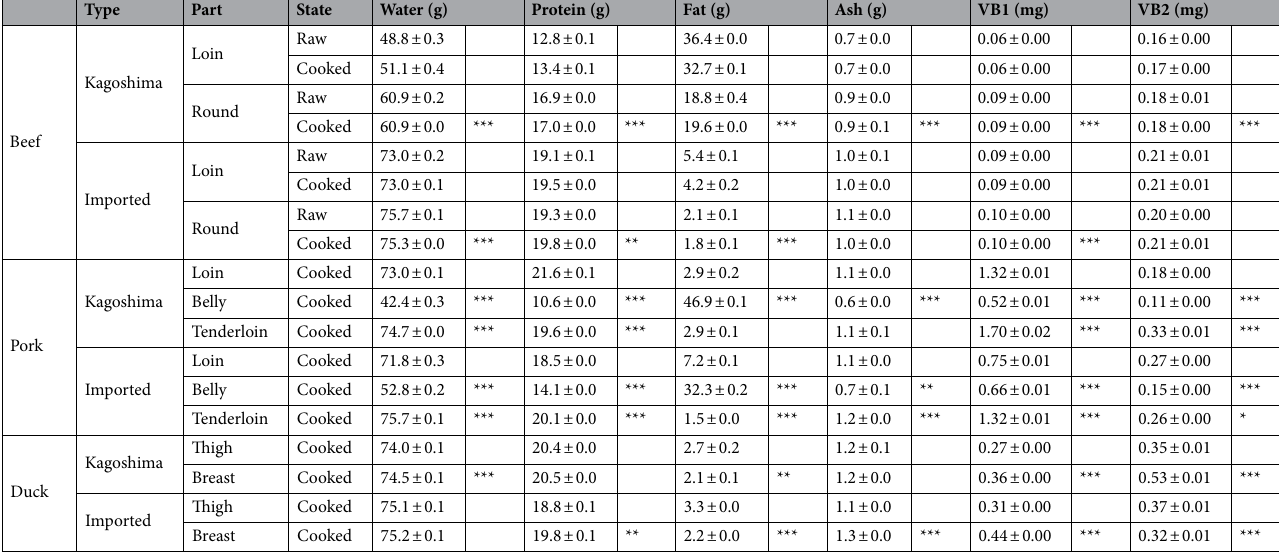
Table 1. Water, protein, fat, ash, VB1, and VB2 contents in the 100-g fresh meat samples. *Indicates P < 0.05 vs. loin (beef and pork) or thigh (duck). **Indicates P < 0.01 vs. loin (beef and pork) or thigh (duck).